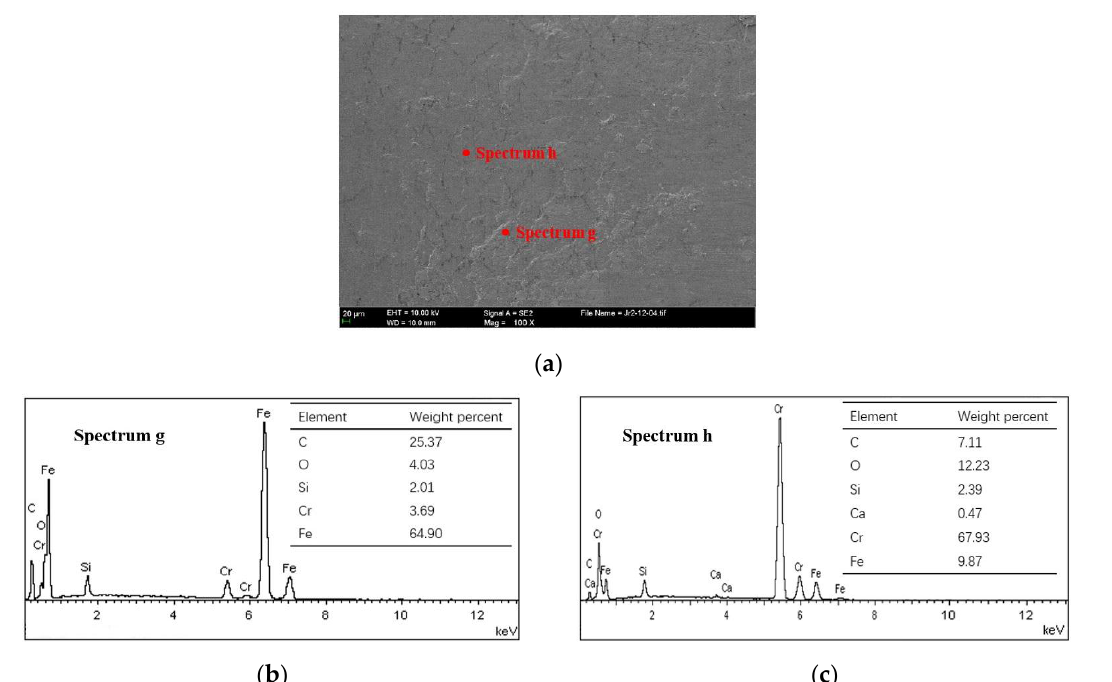
Figure 12. Scuffed piston ring surface and elemental content of CKS/Fe. ( a ) SEM image; ( b ) EDS spectrum g; ( c ) EDS spectrum h. Materials 2017 , 10 , 1176